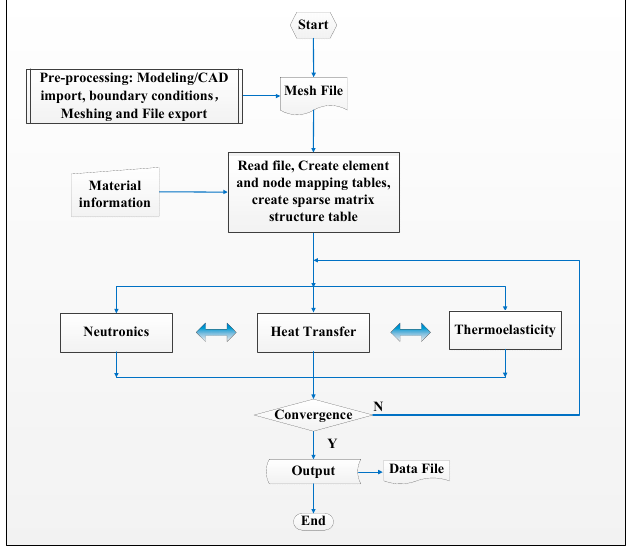
Figure 1. Numerical calculation scheme of neutronics-thermal-mechanical coupling.